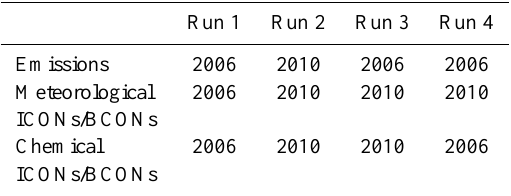
Table 3. Summary of the setup of sensitivity